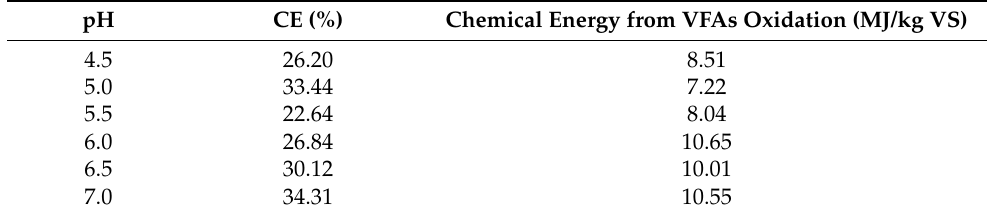
Table 3. Coulombic efficiency and chemical energy from the oxidation of different mixtures of VFAs produced under different pH values, per kg of VS of substrate used in the dark fermentation process. CE (%)